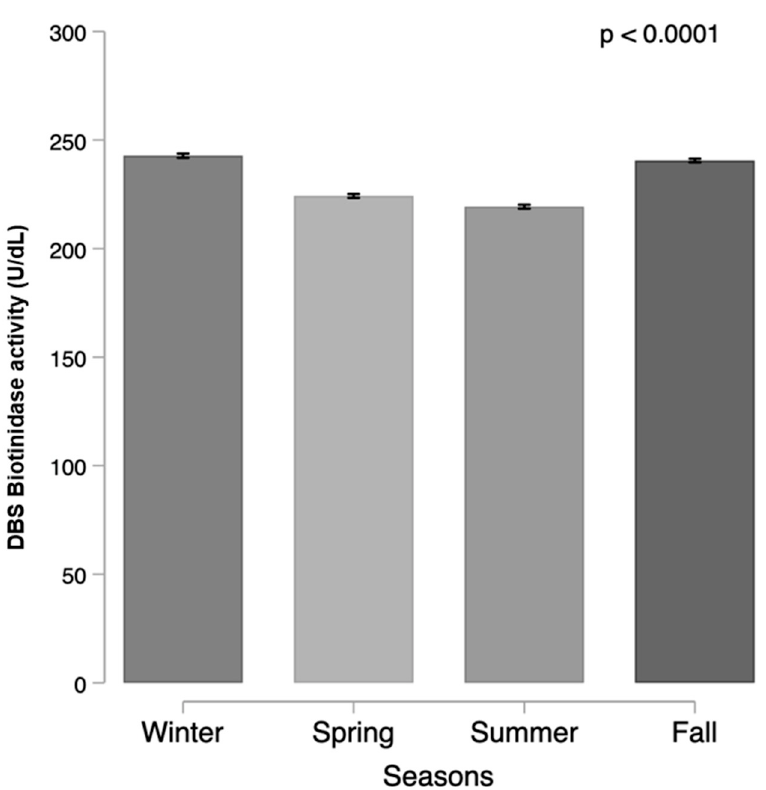
Figure 5. Mean DBS biotinidase activity in relation to the birth season.